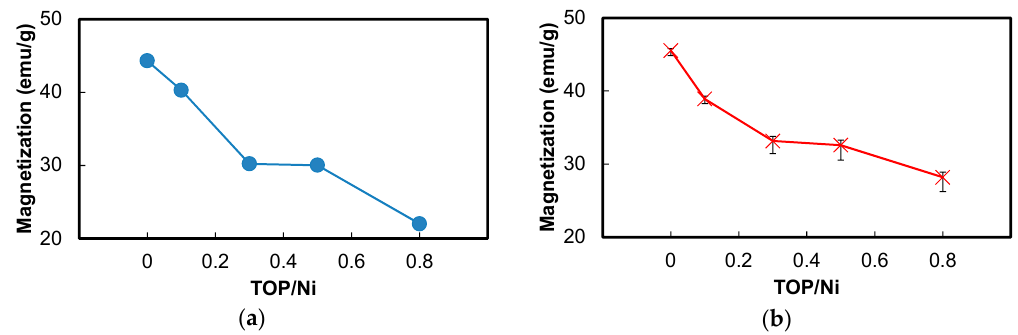
Figure 11. Comparison between the ( a ) measured and ( b ) calculated saturation magnetization values of the Ni nanoparticles at the TOP/Ni ratios from 0–0.8. The calculations were conducted based on the assumption that the interior atoms in the Ni nanoparticles are ferromagnetic, whereas the outermost surface atoms are antiferromagnetic. The error bars in the calculation result was estimated considering the error bars of the mean diameters.